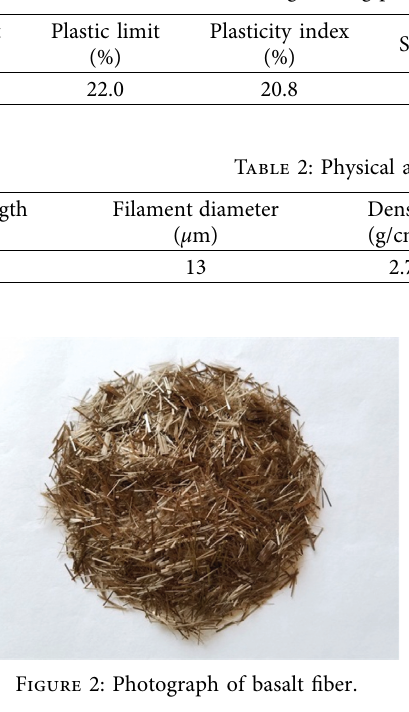
Table 1: Engineering property indices of original soil used in the study.